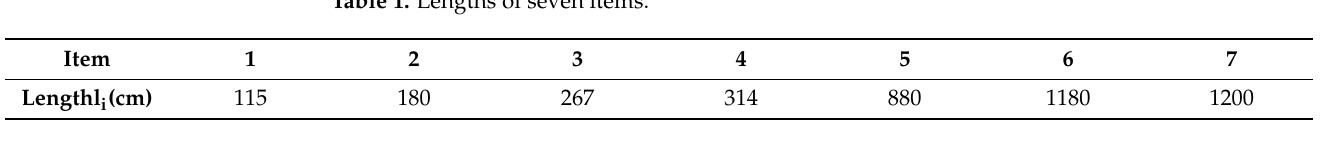
Table 2. Compositions and trim losses of 15 patterns.